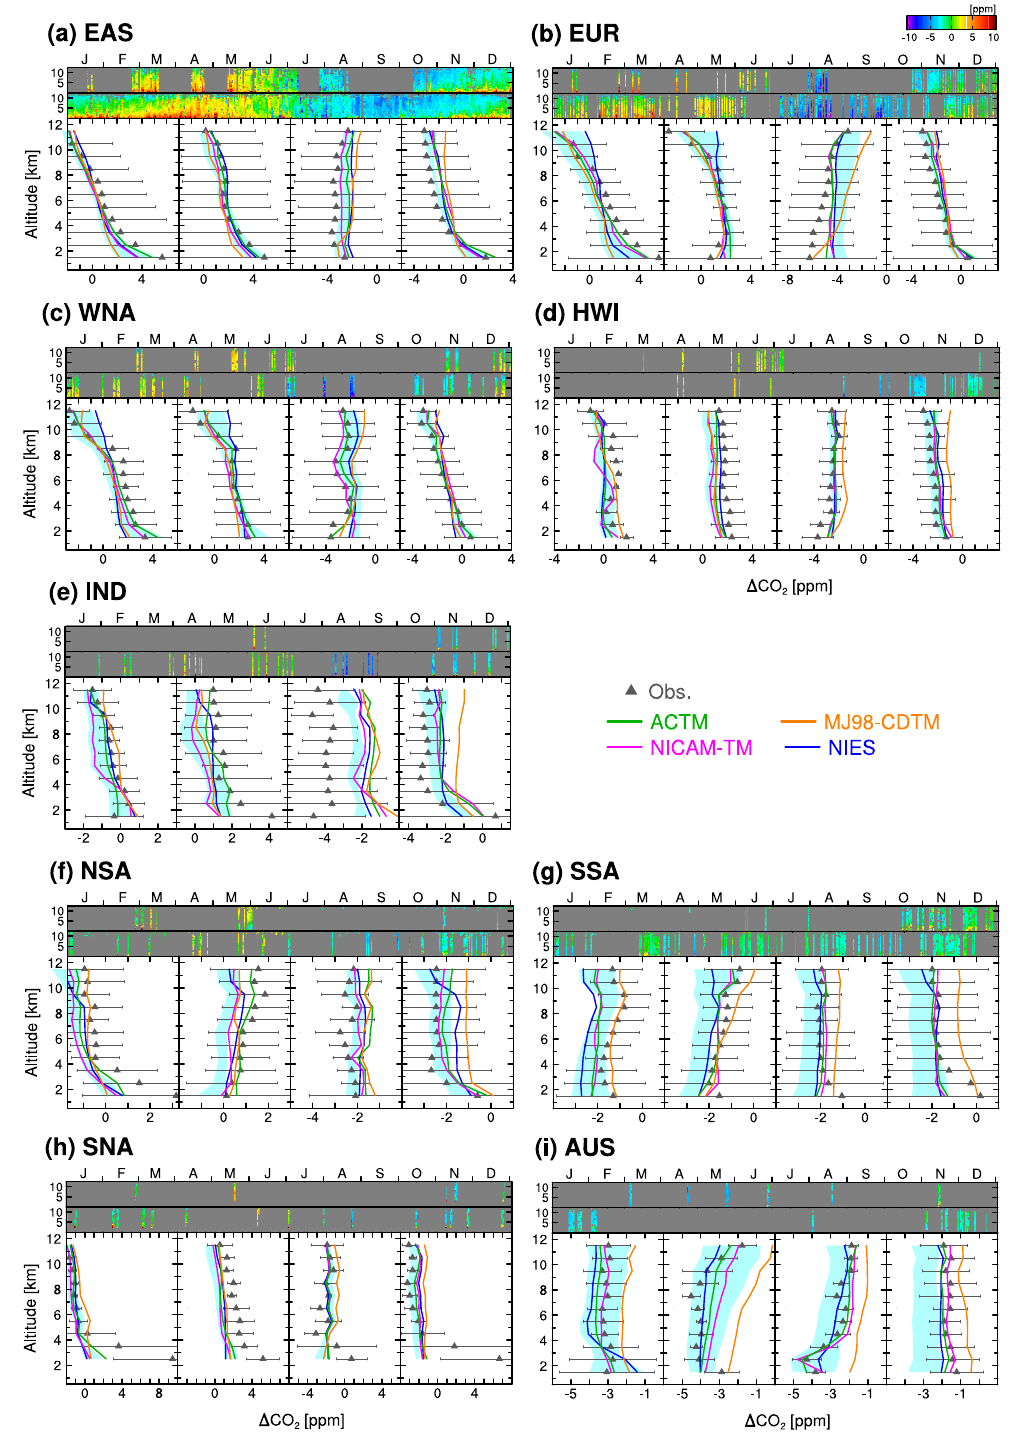
Fig. 5. Seasonal mean vertical profiles of CO 2 over each designated area for 2006–2007. Lines are simulated results using Flux2: ACTM (green), MJ98-CDTM (orange), NICAM-TM (magenta) and NIES (blue). Cyan shading shows the range of the simulated results obtained using Flux1. Gray triangles show the values corresponding to the CONTRAIL measurements. The error bar indicates the variation of the instantaneous data, derived by averaging the standard deviations of the instantaneous data within each grid at each level. Vertical profiles are seasonally averaged for January-February-March (JFM), April-May-June (AMJ), July-August-September (JAS), and October-November- December (OND). The top two panels (with gray background) in each figure show time-altitude cross-section of daily 1 CO 2 from the CONTRAIL data for 2006 (upper panel) and 2007 (lower